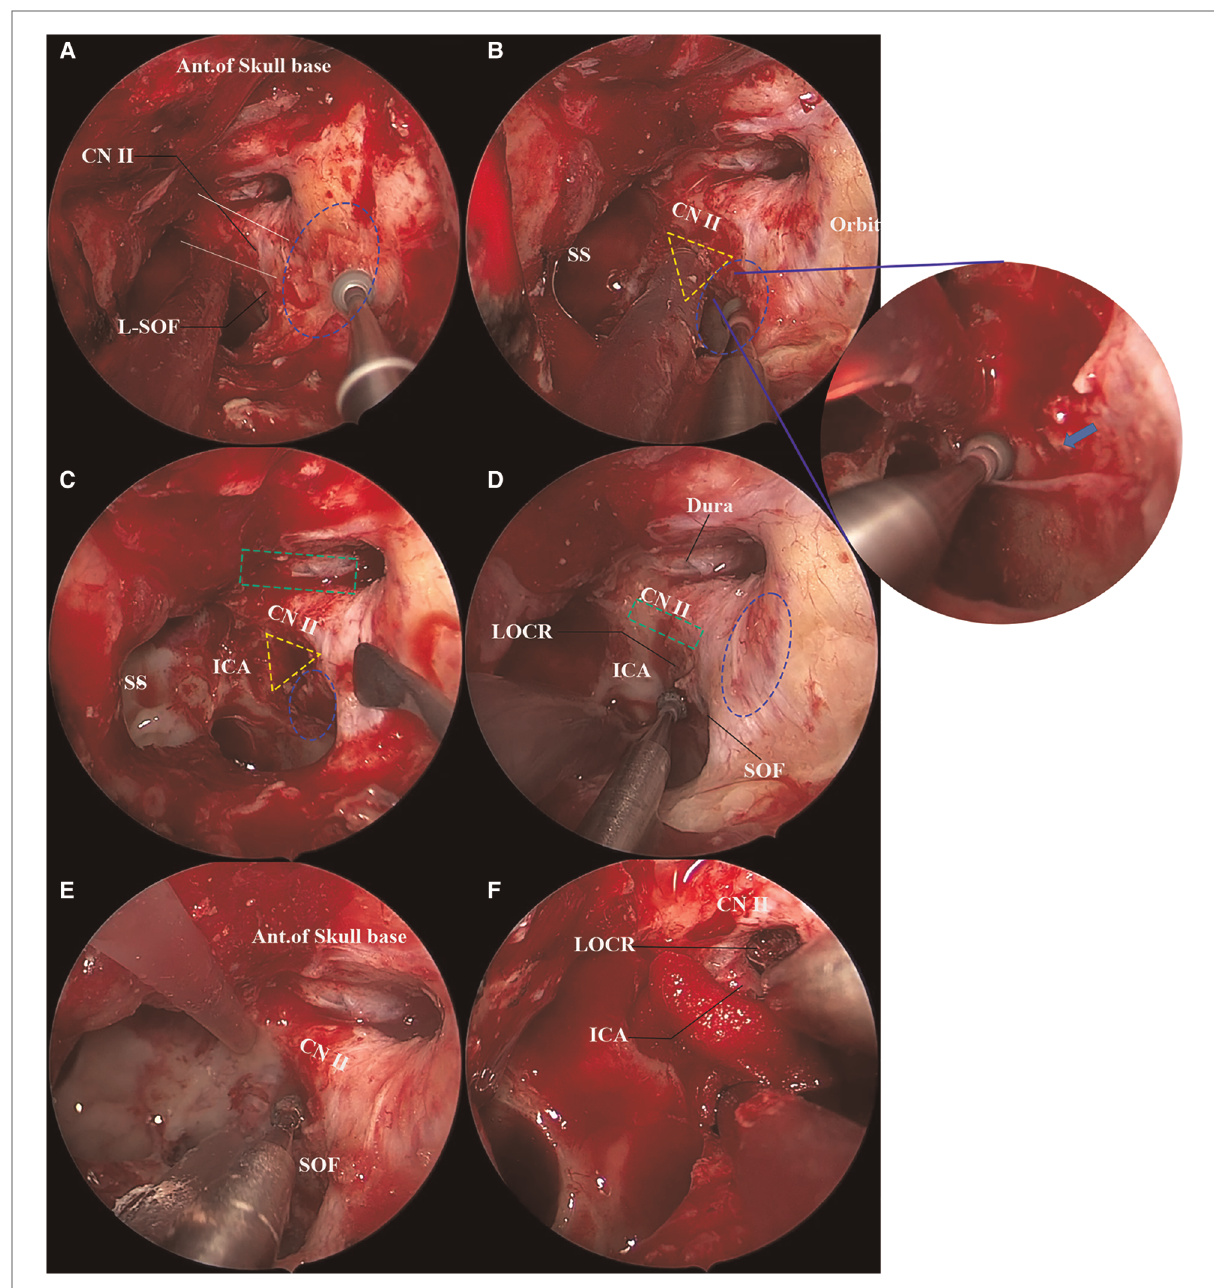
FIGURE 4 Transnasal endoscopic decompression of oculomotor nerve through the optic strut. The yellow dotted triangle area is the approximate range of the optic strut triangle. ( A ) The lateral wall of the left sphenoid sinus is exposed and the orbital apex decompression is performed. The orbital apex bone is being eggshelled using a high-speed burr in the fi gure. The sphenoid sinus pneumatization of this patient is poor, and the LOCR is not clearly displayed. The blue dotted oval area depicts the range of the orbital apex and the white solid line the range of the optic nerve, and the anterior skull base is in the upper fi eld of view. ( B ) Nasal endoscopic decompression of superior orbital fi ssure. The blue dotted oval area shows the superior orbital fi ssure. The optic strut triangle can be observed, but its boundary is unclear. The superior orbital fi ssure bone is being eggshelled using a high-speed burr in the fi gure. The right image shows a magni fi cation of the superior orbital fi ssure, with a fracture line (blue arrow) below the mucosa. ( C ) Decompression of optic canal. After decompression of the inferomedial and superior walls of the optic canal, the anterior skull base dura mater (green dotted rectangle) is exposed. The blue dotted oval area shows the range of the superior orbital fi ssure. ( D ) The boundary of the optic strut triangle is de fi ned. The inferior wall of the optic nerve (green dotted rectangle) is eggshelled, and the bone around the optic strut triangle is ground to determine its boundary. The blue dotted oval area is the range of the orbital apex. ( E ) Decompression of the optic strut. The optic strut is decompressed under continuous water fl ow; it can be seen that a 180° decompression is achieved for the optic nerve, and both the superior orbital fi ssure and orbital apex are suf fi ciently decompressed. ( F ) The optic strut is eggshelled, the optic strut is removed, and the oculomotor nerve fi ssure segment is suf fi ciently